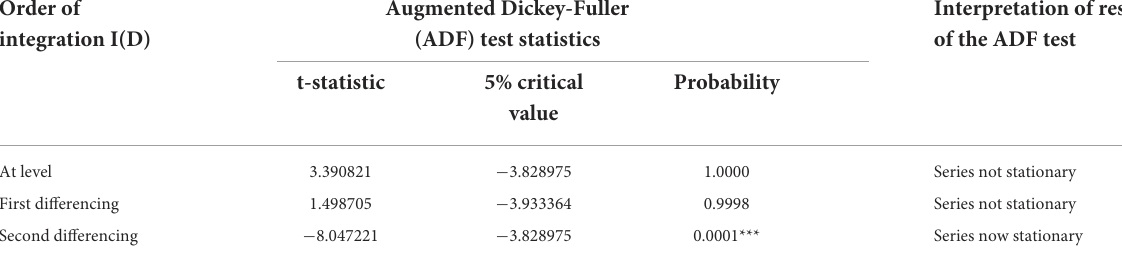
TABLE 3 Unit root test.